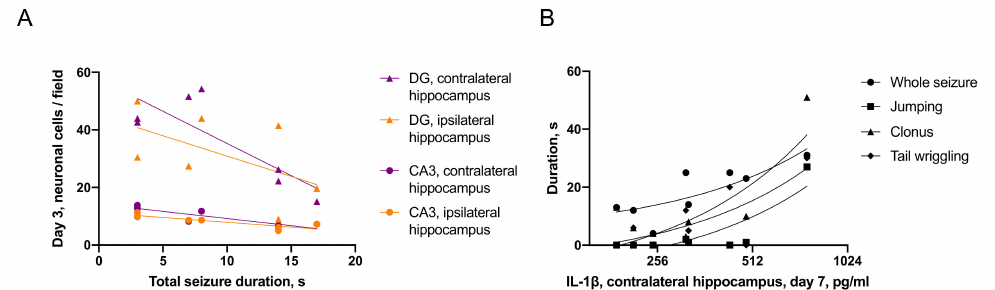
Figure 4. Associations between immediate seizures and distant hippocampal damage. ( A )—Duration of immediate seizure correlates with neuronal cell loss in the hippocampus on day 3 after TBI (n = 7). ( B )—Duration of immediate seizure elements correlates with the level of IL-1 β in the contralateral hippocampus on day 7 after TBI (n = 8).